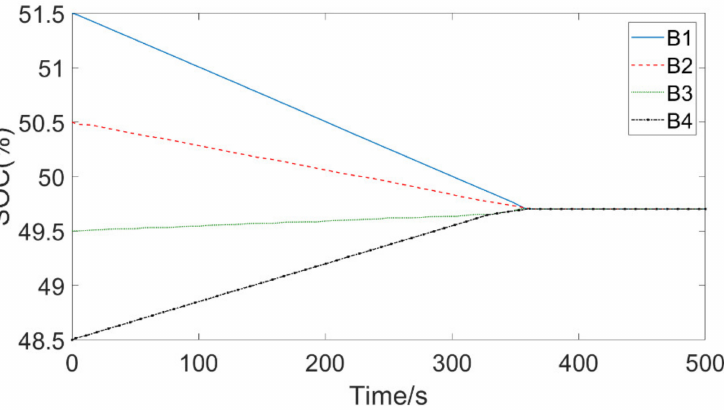
Figure 4. Simulation of cascaded Buck-Boost balance circuit based on fuzzy control.